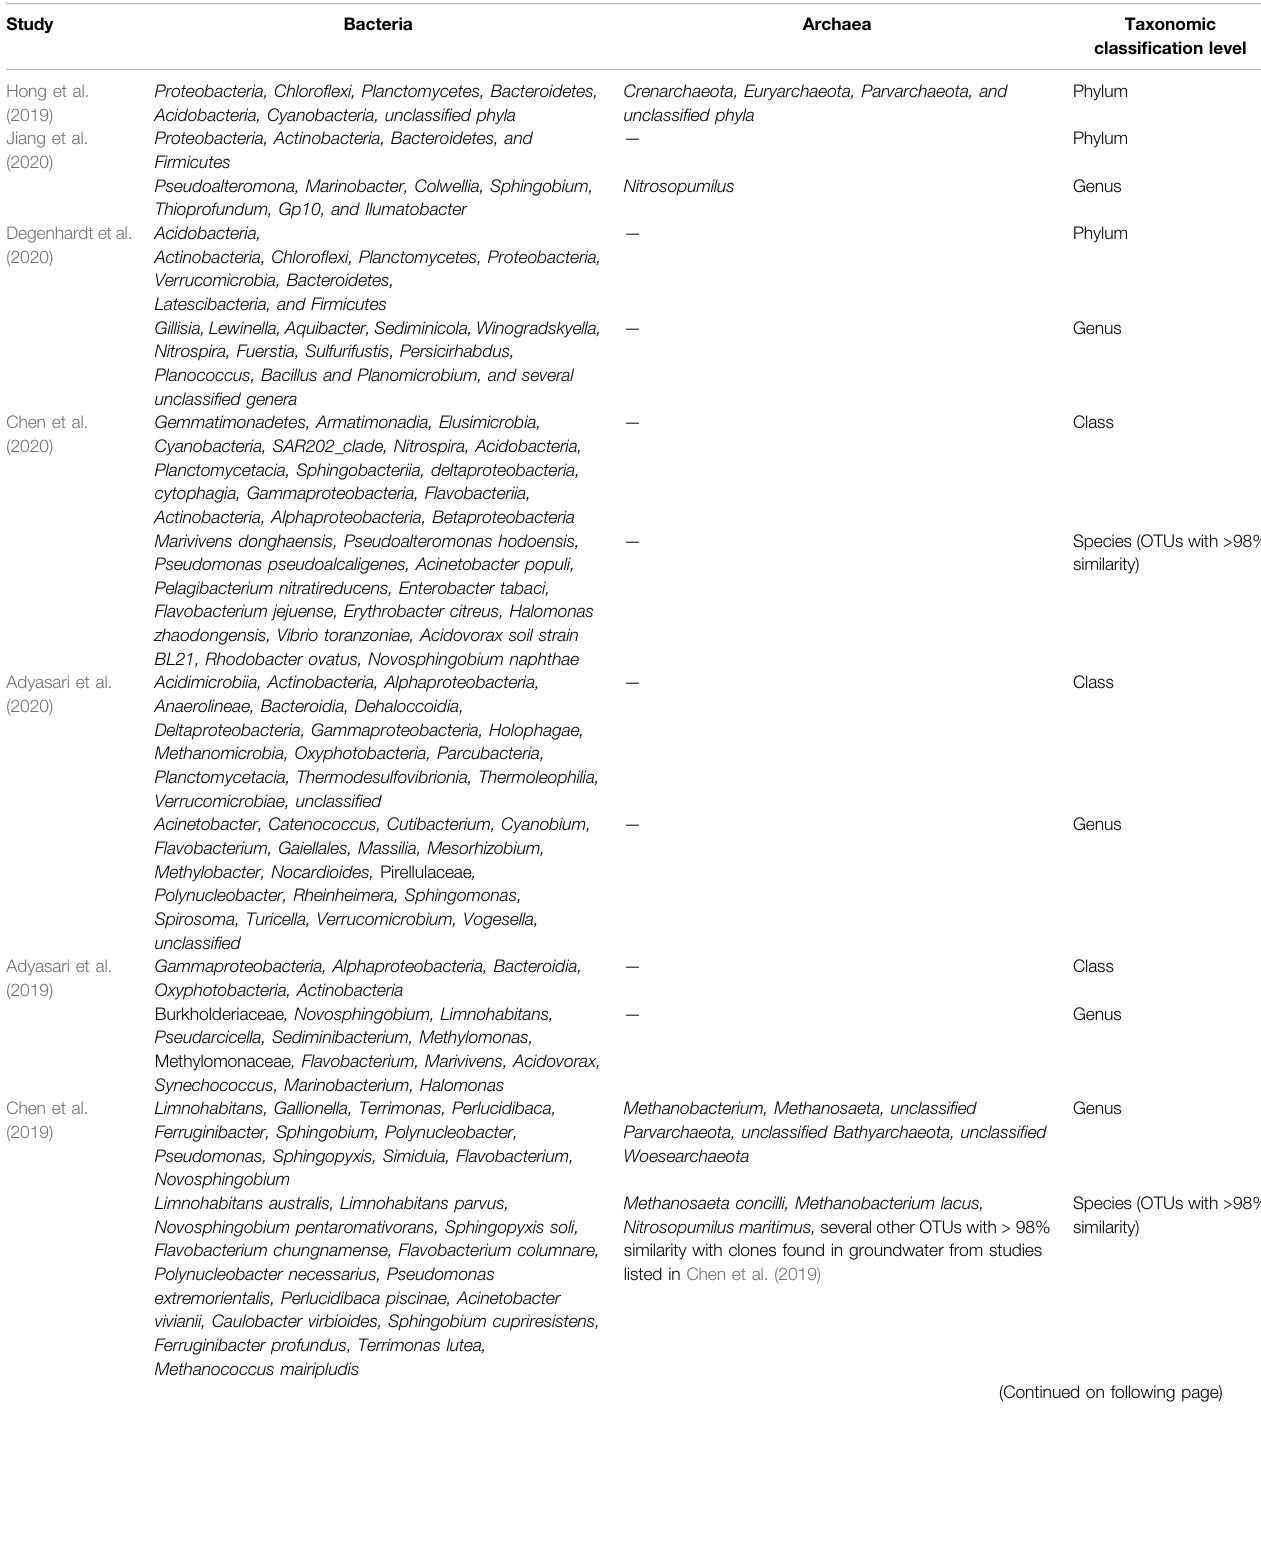
TABLE2| Summaryofmicrobialcommunitiesinbeachaquifers.Theorganismslistedwereextractedfrom fi guresandtablesprovidedintheoriginalstudy,thelistsincludeall the organisms in the